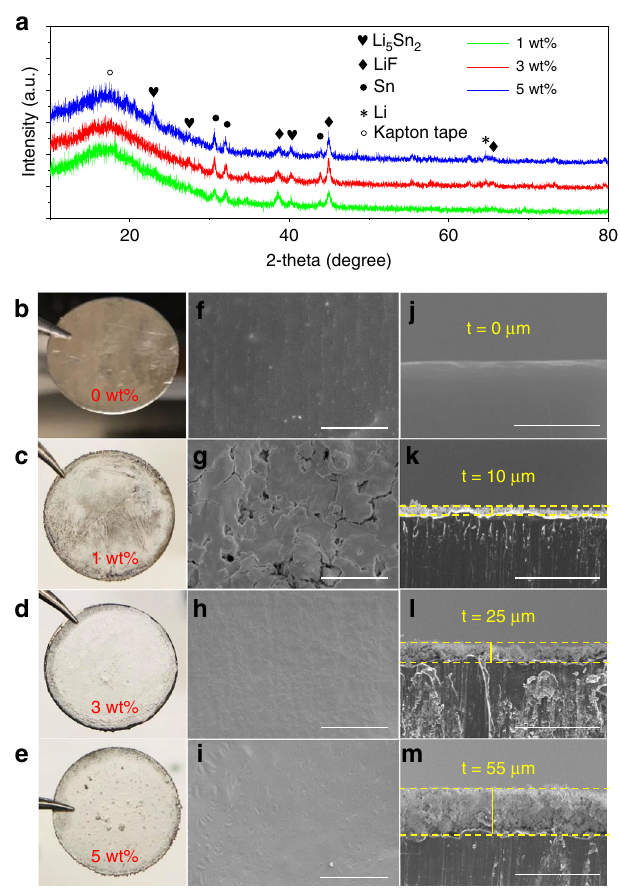
Fig. 2 Structural and morphological characterizations. a XRD spectrum of Li electrode treated with 1, 3, and 5 wt% SnF 2 . b – e Photographic images of Li with different weight percentage concentrations of SnF 2 . f – i The corresponding top-view SEM images from b to e . The scale bars are 20 μ m. j – m The corresponding cross-sectional SEM images from f to i . The scale bars are 100 μ